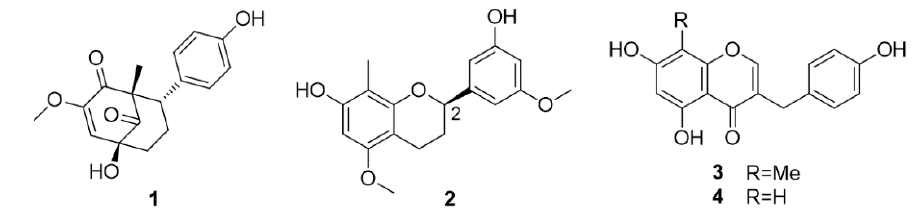
Figure 2. Chemical structures of compounds 1 – 4 isolated from D. angustifolia.